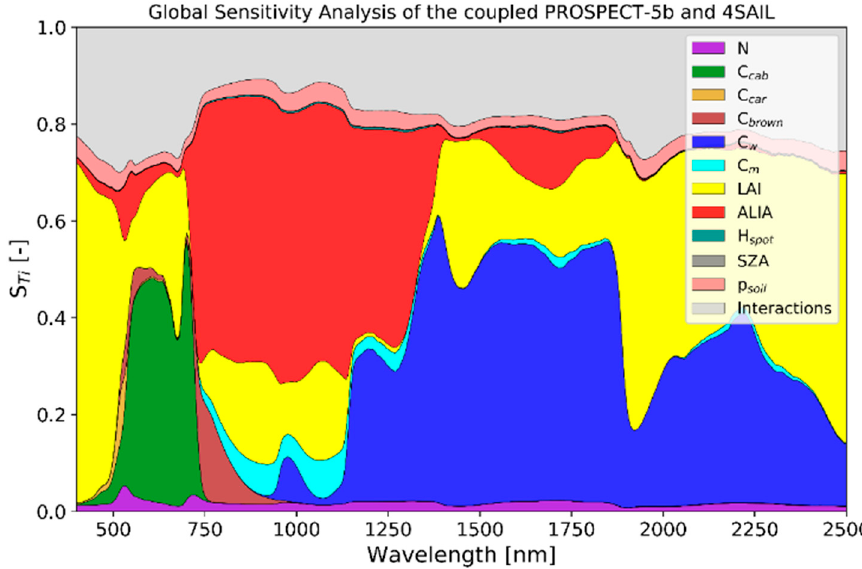
Figure 2. Global Sensitivity Analysis of the coupled PROSPECT-5b and 4SAIL models. The dimensions of sensitivity refer to the Sobol score and denote the relative contribution (S Ti ) of each input variable, and their interactions, to the variance of the model output. Parameter ranges: N: 1.0–2.5; C ab : 0.0–80.0 µ g cm − 2 ; C car : 0.0–15.0 µ g cm − 2 ; C brown : 0.0–1.0; C w : 0.0–0.07 cm; C m : 0.0–0.02 g cm − 2 ; LAI: 0.0–8.0; ALIA: 0.0–88.0; H spot : 0.0–0.1; p soil : 0.0–1.0; SZA: 30, 35, 40, 45, 50, 55°; OZA: 0°; rAA: 0°.